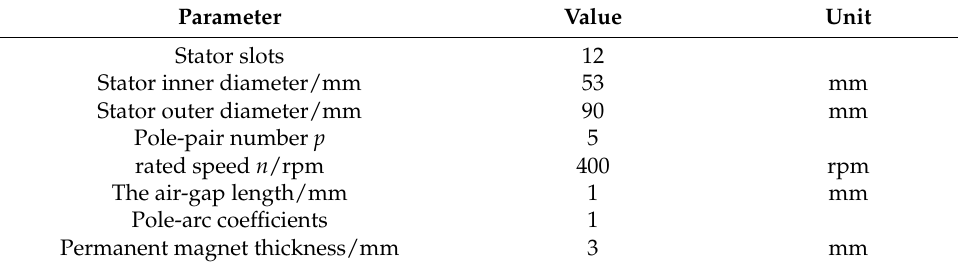
Table 7. Parameters of conventional dual three-phase